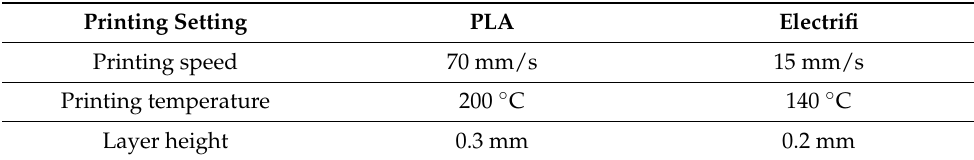
Table 4. 3D-printing settings for PLA and Electrifi filaments.